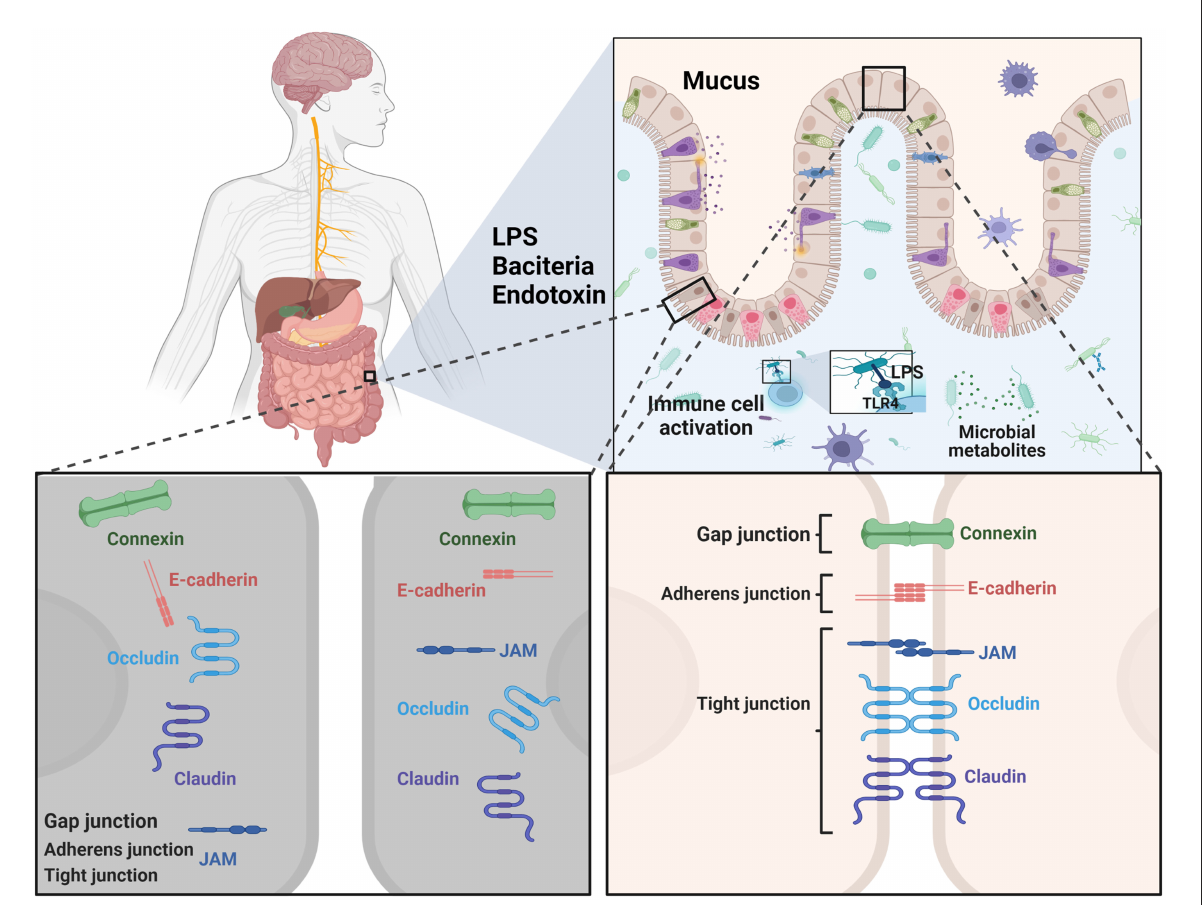
FIGURE3 A schematic overview of the main cell types and physical defense mechanisms as targets related to intestinal barrier function for therapeutic strategies in